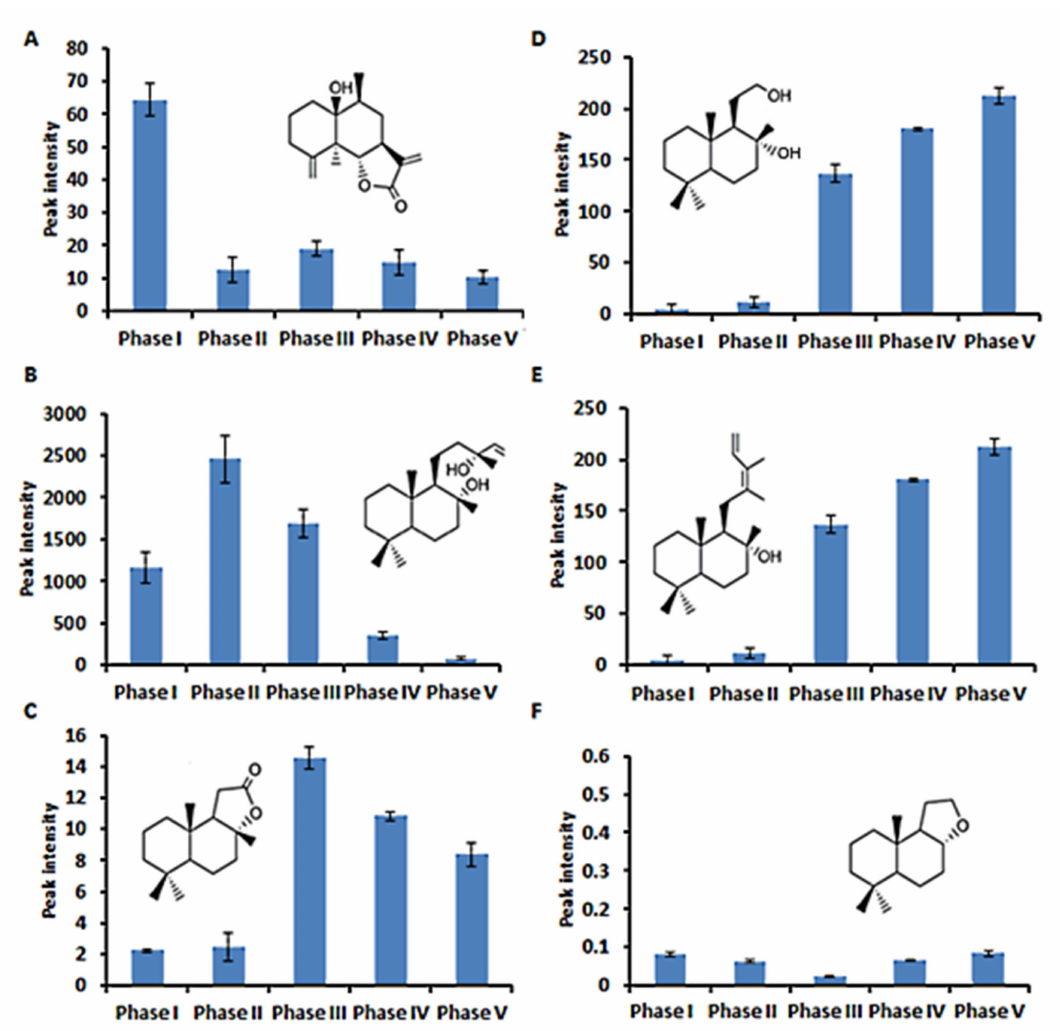
Figure 6. Annotated intermediate compounds of the sclareol bioconversion process with the re- spective peak intensities at different harvest-times. Compounds include reynosin ( A ), sclareol ( B ), sclareolide ( C ), ambradiol ( D ), abienol ( E ) and ambrafuran-related ( F ). The intensity variations re- flected on different concentrations, indicative of the harvest time at which each compound was at its highest relative concentration. The bar graphs were constructed using average values of peak intensities, where 3 biological replicates per sample were analyzed in triplicate (error bars indicate the standard deviation, n =